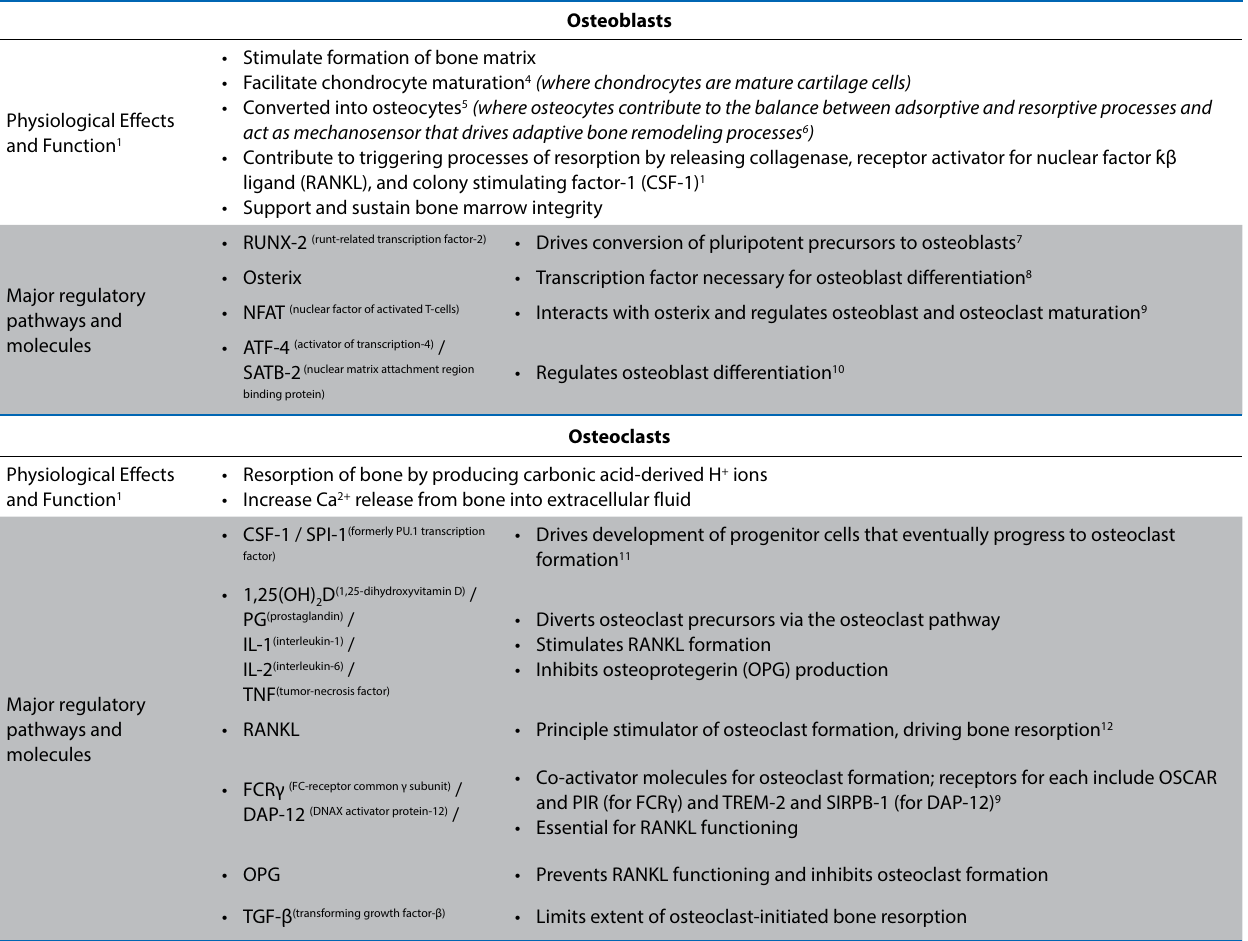
Table 1: Major functions of and regulatory processes involved in osteoblast and osteoclast action